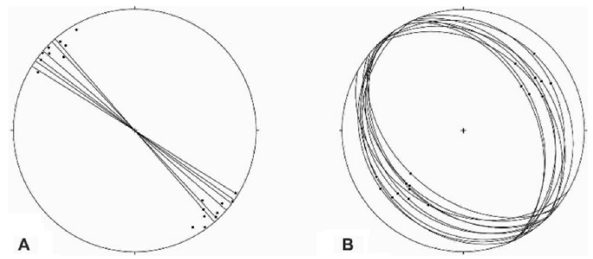
Figure 10. ( A ) Stereographic projection from the lower hemisphere showing the trend of map-scale folds (lines; No. = 7) and the attitudes of the axes of the outcrop-scale folds (points; No. = 19). ( B ) Stereographic projection from the lower hemisphere showing the attitudes of the outcrop-scale thrusts (No. =